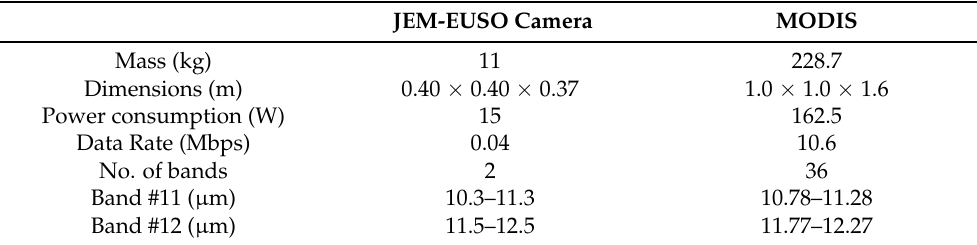
Table 1. Specifications of a initial IR camera on board JEM-EUSO instrument [19] and MODIS instrument